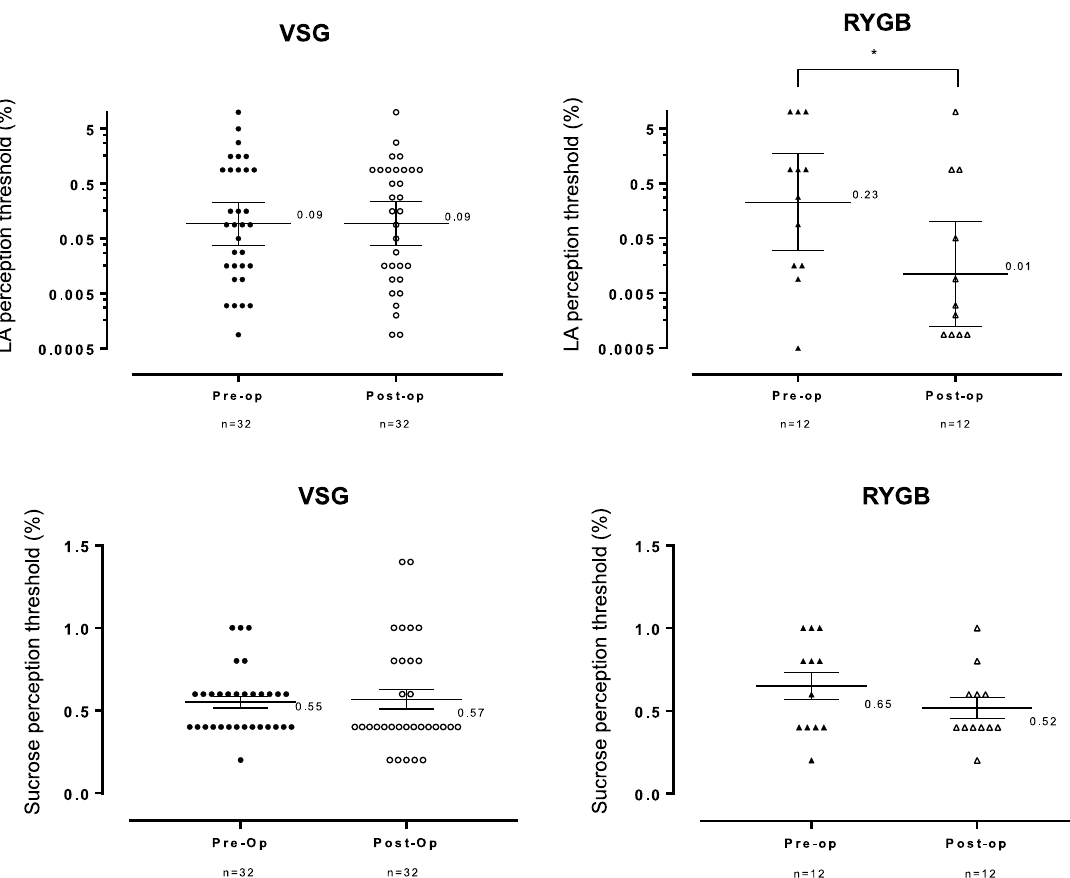
Figure 2. ( A ) Linoleic acid (LA) and ( B ) sucrose orosensory perception thresholds before and 6 months after vertical sleeve gastrectomy (VSG) or Roux-en-Y gastric bypass (RYGB) using the 3-alternative force-choice tests. Ascending concentrations of LA (from 0.00028% to 5% LA with 0.25 log units space, wt/wt) and sucrose (from 0.2% to 1.6% sucrose with increments of 0.2 g, wt/wt) were assessed. Geometric means, comparisons of perception thresholds before vs. after surgery were performed using a paired Wilcoxon–Pratt test. *, p < 0.05. Pre-op, preoperated; post-op,